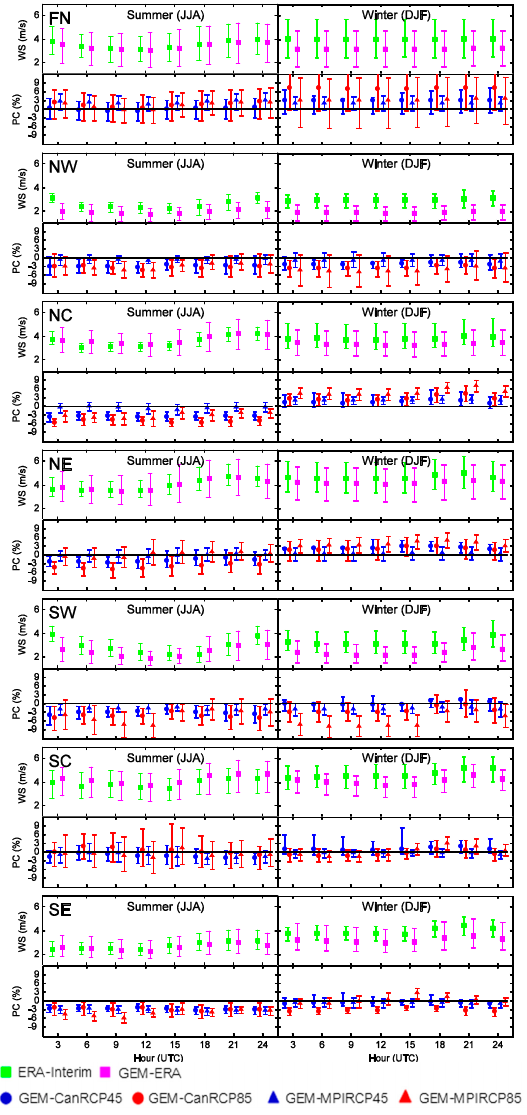
Figure 6. Diurnal 3-hourly mean wind speed (WS) for ERA-Interim reanalysis and GEM-ERA simulation for the seven sub-regions of NA for the 1981–2010 period (upper panel in each sub-plot) for summer and winter based on all grid pints of each sub-region. Projected change (PC; in %) to 3-hourly mean wind speeds for the four GEM model simulations for the 2071–2100 period with respect to the 1981–2010 period are presented in the lower panel of each sub-plot. Symbol and error-bar represent median and 1-sigma (15.9~84.1%) range, respectively.